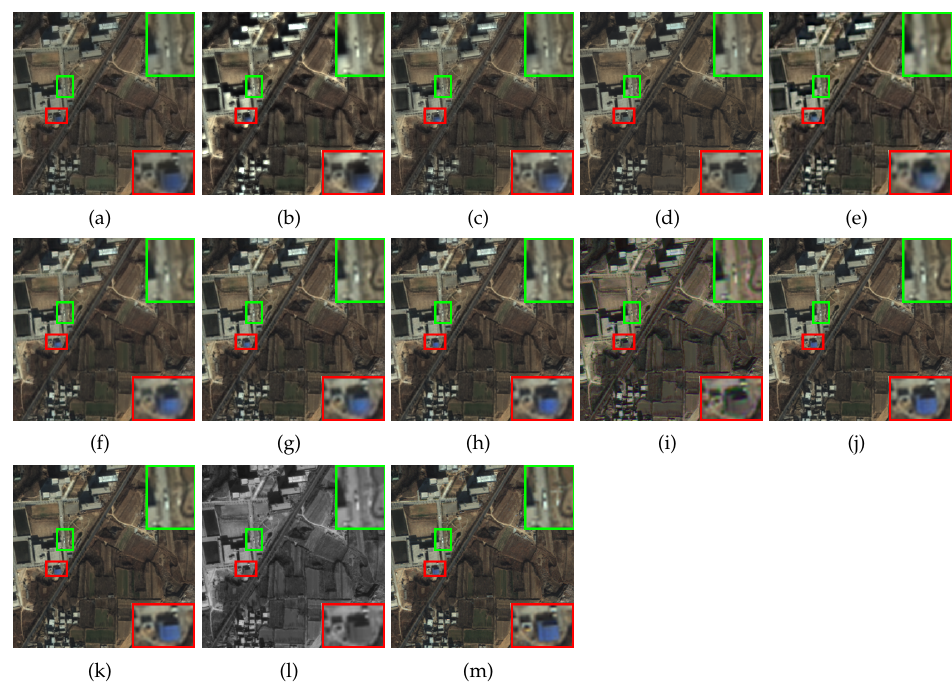
Figure 6. Qualitative comparison of MPFINet with ten counterparts on a sample from the QB dataset. ( a ) Brovey. ( b ) MTF_GLP_HPM. ( c ) SFIM. ( d ) CNMF. ( e ) PNN. ( f ) PANNET. ( g ) SRPPNN.